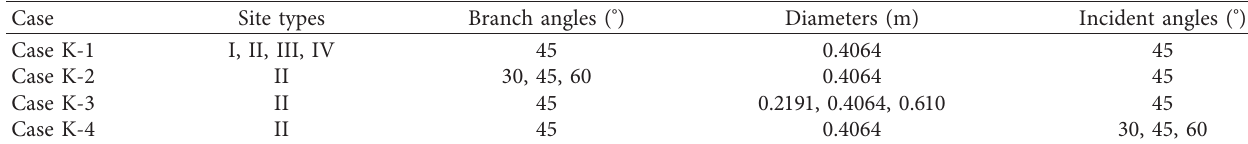
Figure 23: K-shaped connections with different branch angles. Table 13: Parameters of K-shaped connection in different cases.